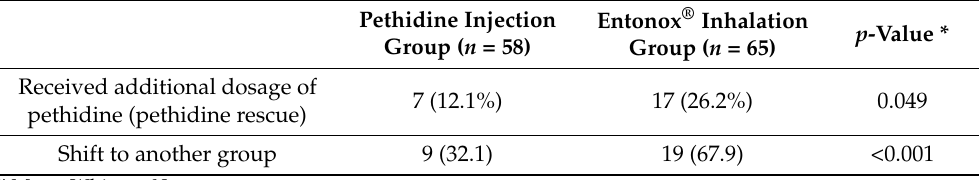
Figure 2. Boxplots comparing pain scores at baseline, 30 min, 60 min, 90 min, and 120 min ( A – E ), respectively; as well as satisfaction score ( F ), between both groups. Table 4. Additional dose of pethidine injection and switching group data. Table 1. Comparisons of baseline maternal characteristics between pethidine injection group and Entonox ® inhalation group.